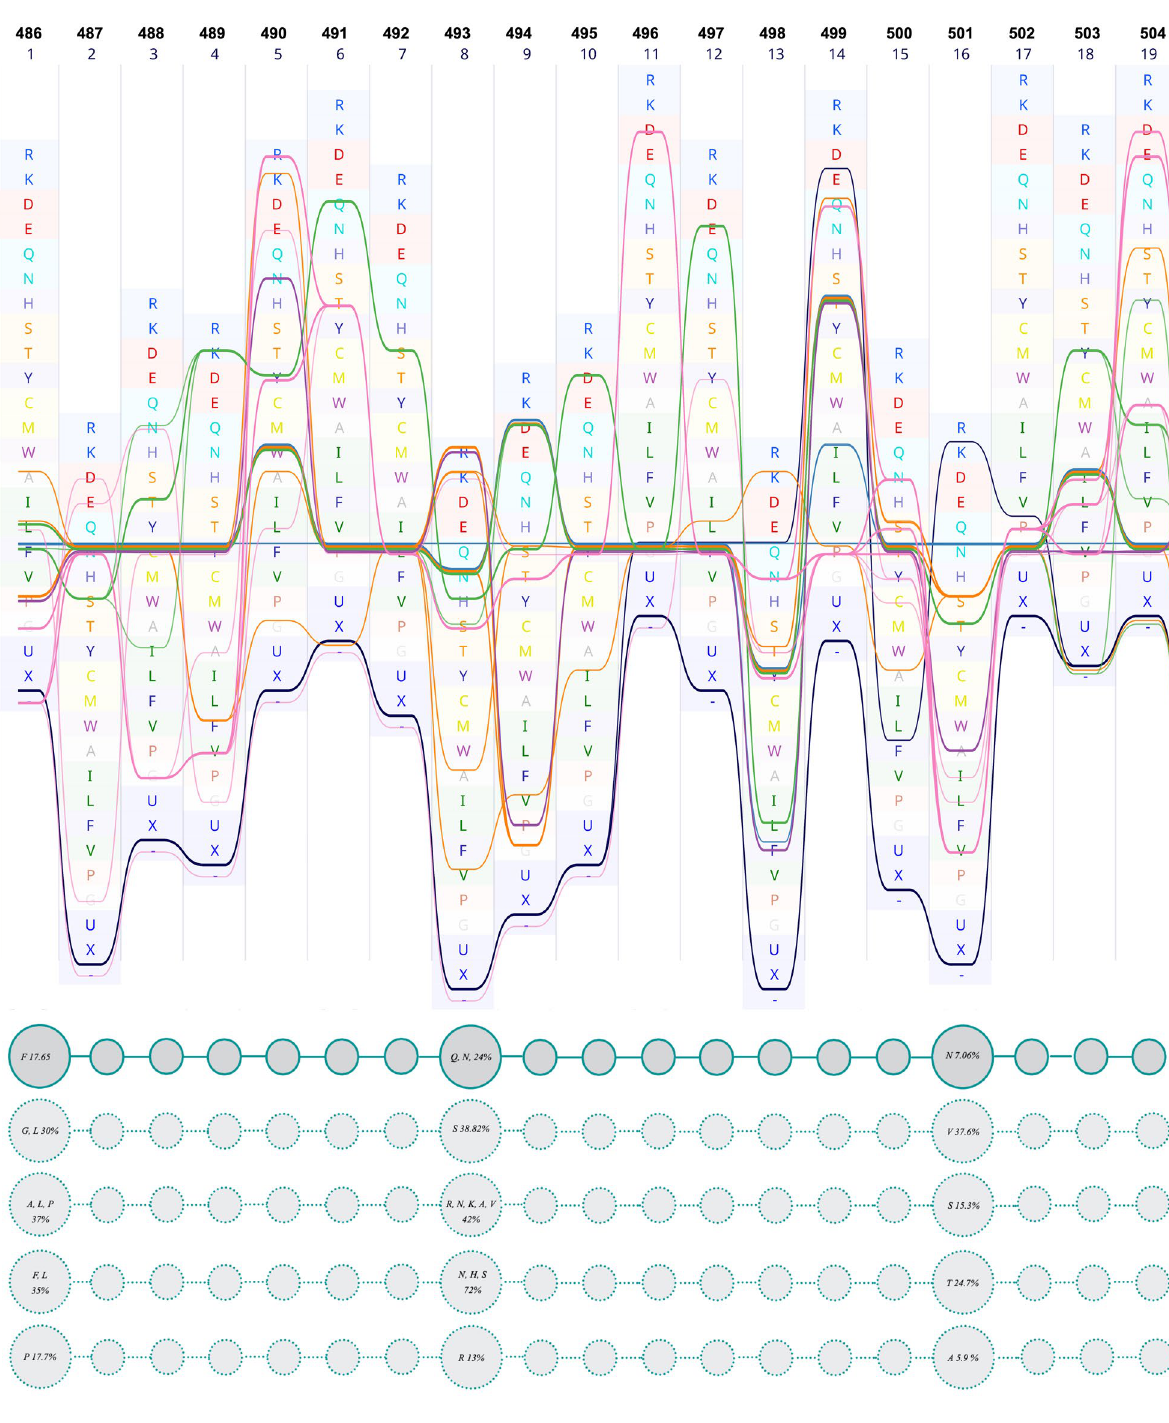
Figure 4. Multiple sequence alignment of RBM. In this figure, the sequence of RBM SARS-CoV-2 is set as the reference (upper panel). The lower panel schematically represents the respective residues and their location. The first line of circles presents the segment of RBM SARS-CoV-2 , the other four lines represent four other groups of sequences at which those aforesaid positions are occupied by other amino acids. The numbers in the circles are the sum of the occurrence percentage of respective